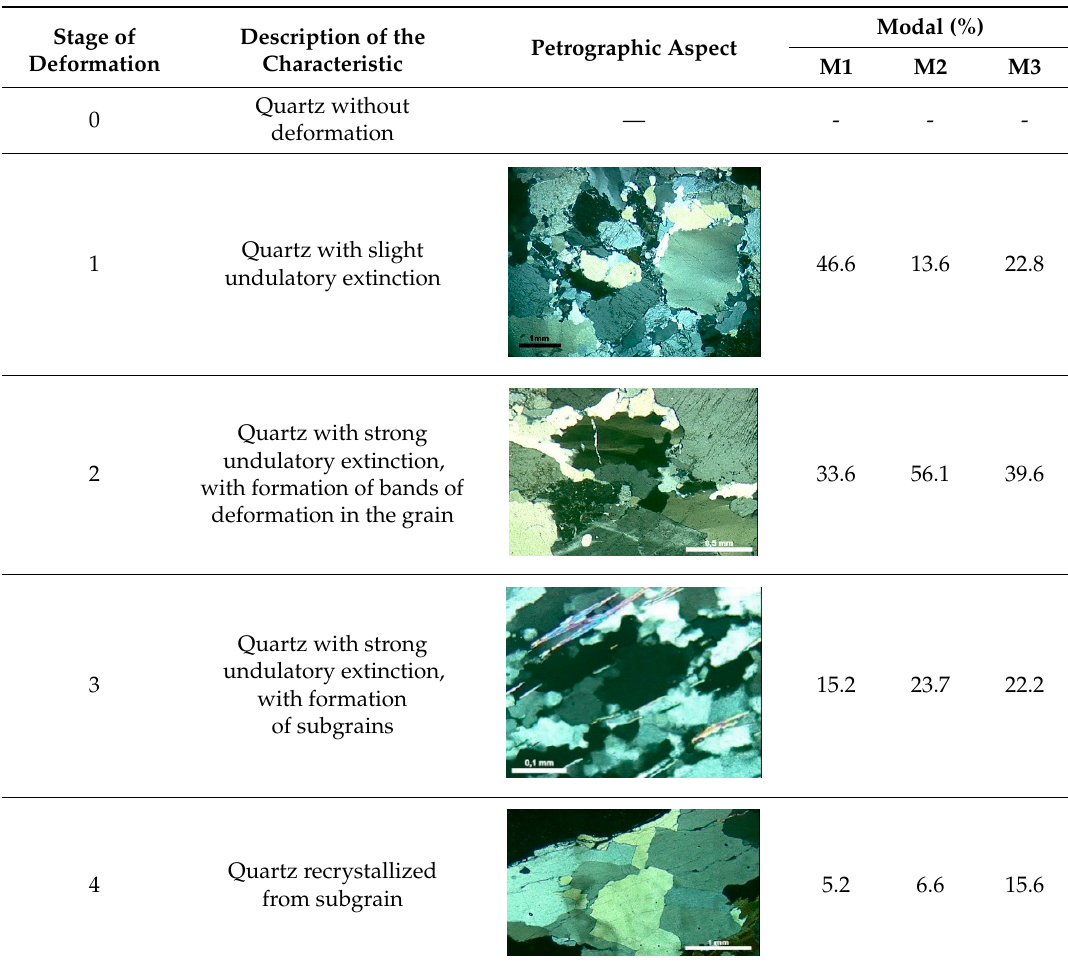
Table 3. Quantification of the phases present in the quartz and feldspar samples, using Rietveld refinement of XRD spectra.